Question: What type of chart is this?
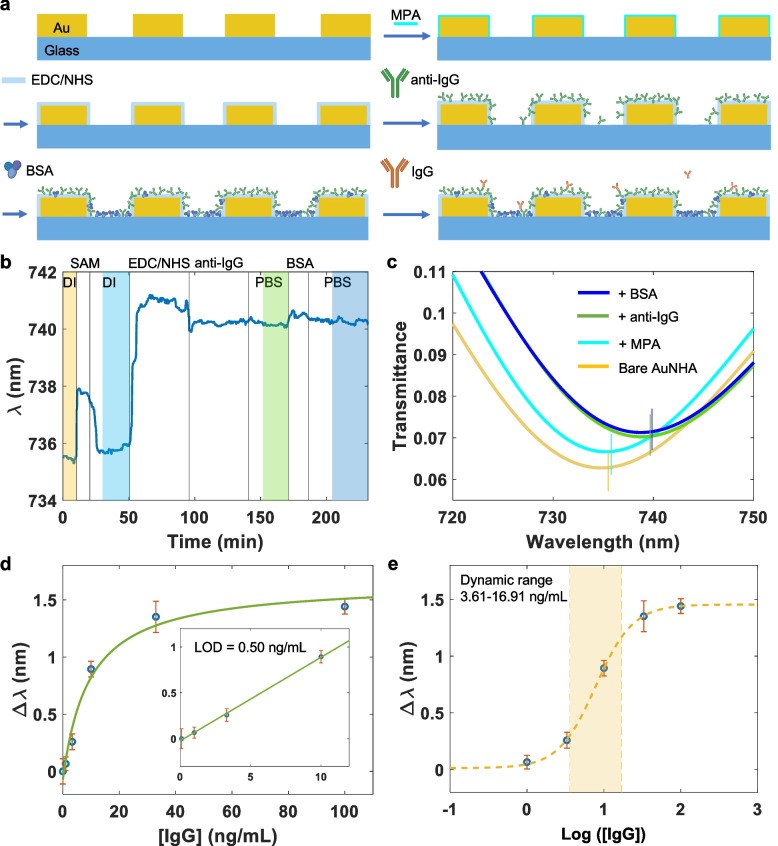
Answer: bar